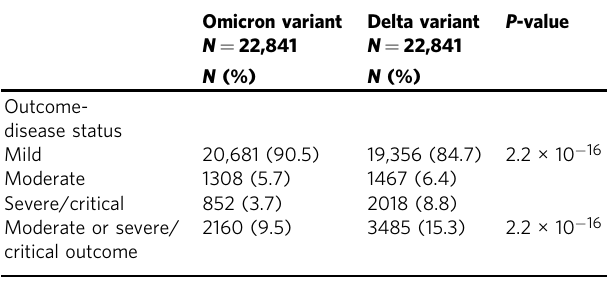
Supplementary Table 3. A signi fi cantly lower proportion of